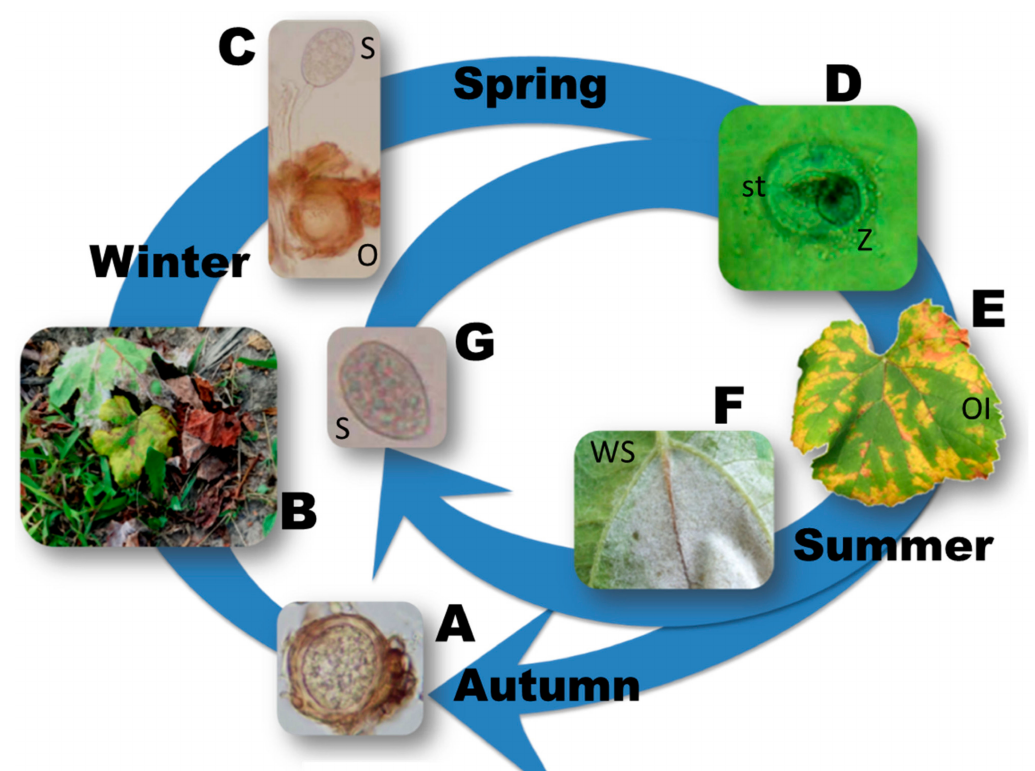
Figure 1. Disease cycle of P. viticola : the pathogen survives the winter period as oospores, i.e., the overwintering structures differentiated by sexual reproduction in autumn ( A ), embedded in dead leaves on the vineyard floor ( B ). With favorable weather conditions, oospores typically produce sporangia ( C ) that, in turn, produce zoospores ( D ). Zoospores are splashed by rain onto leaves and other receptive tissues of the grapevines, originating the primary infections through stomata penetration ( D ). Disease symptoms, visible as yellow discoloration (oil spots, Ol) on the upper side of the leaves ( E ), appear at the end of the incubation period and are followed, in high humidity conditions, by the emission of sporangiophores ( F ) with sporangia ( G ) that will cause secondary infections through the emission of new zoospores. O = oospore; S = sporangium; st = stoma; Z = zoospore; OI = oil spot symptom on the upper side of the leaf; WS = white sporulation, consisting of sporangiophores and sporangia, on the underside of the